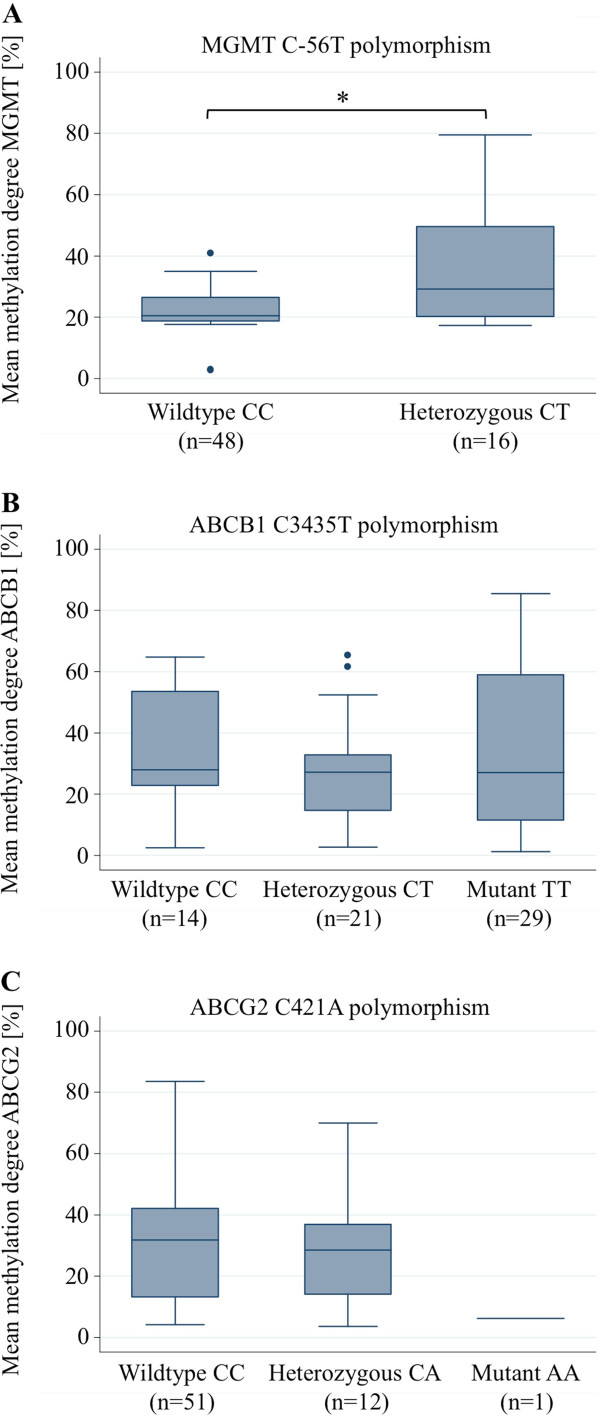
Relation between MGMT, ABCG2 or ABCB1 promoter methylation and selected SNPs. (A) Bivariate analysis of the association between the MGMT promoter methylation and the MGMT C-56 T polymorphism (Wilcoxon test, p = 0.02). (B) Bivariate analysis of the association between the ABCG2 promoter methylation and the ABCG2 C421A polymorphism (Kruskal-Wallis test, p = 0.30). (C) Bivariate analysis of the association between the ABCB1 promoter methylation and the ABCB1 C3435T polymorphism (Kruskal-Wallis test, p = 0.63).